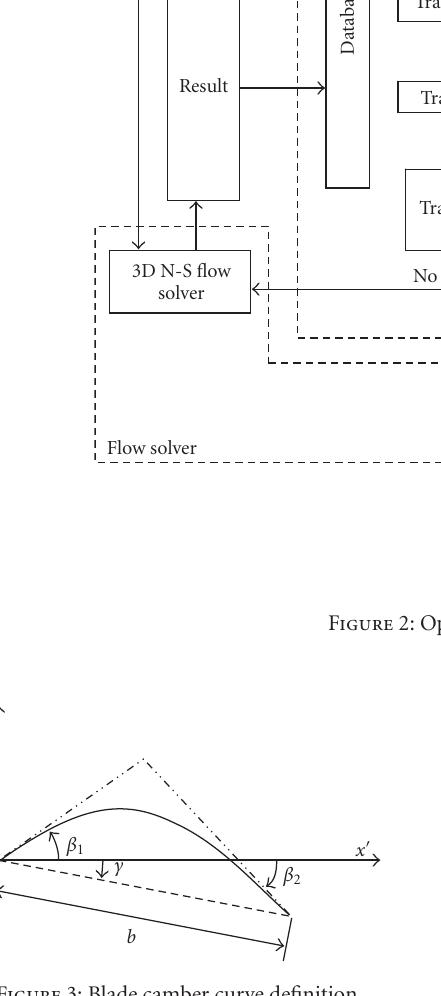
Figure 3: Blade camber curve definition. Figure 4: 2D-blade profile